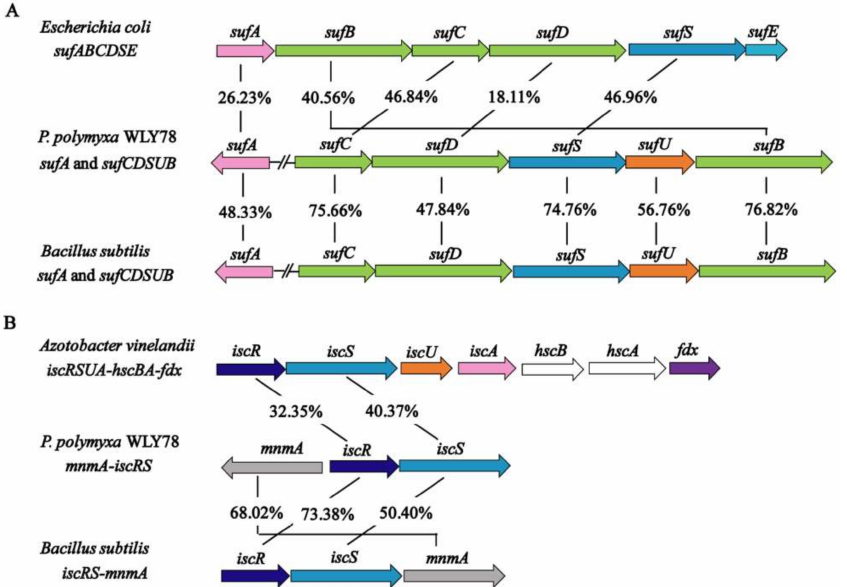
Figure 2. Comparison of the P. polymyxa WLY78 suf and isc cluster with other bacteria. ( A ) Compari- son of the P. polymyxa sufCDSUB operon and the sufA gene with Escherichia coli and Bacillus subtilis suf operons and sufA genes. ( B ) Comparison of the P. polymyxa iscRS operon with the Azotobacter vinelandii and B. subtilis isc operons. For gene products with similar sequences, their amino acid identity (%) is indicated.